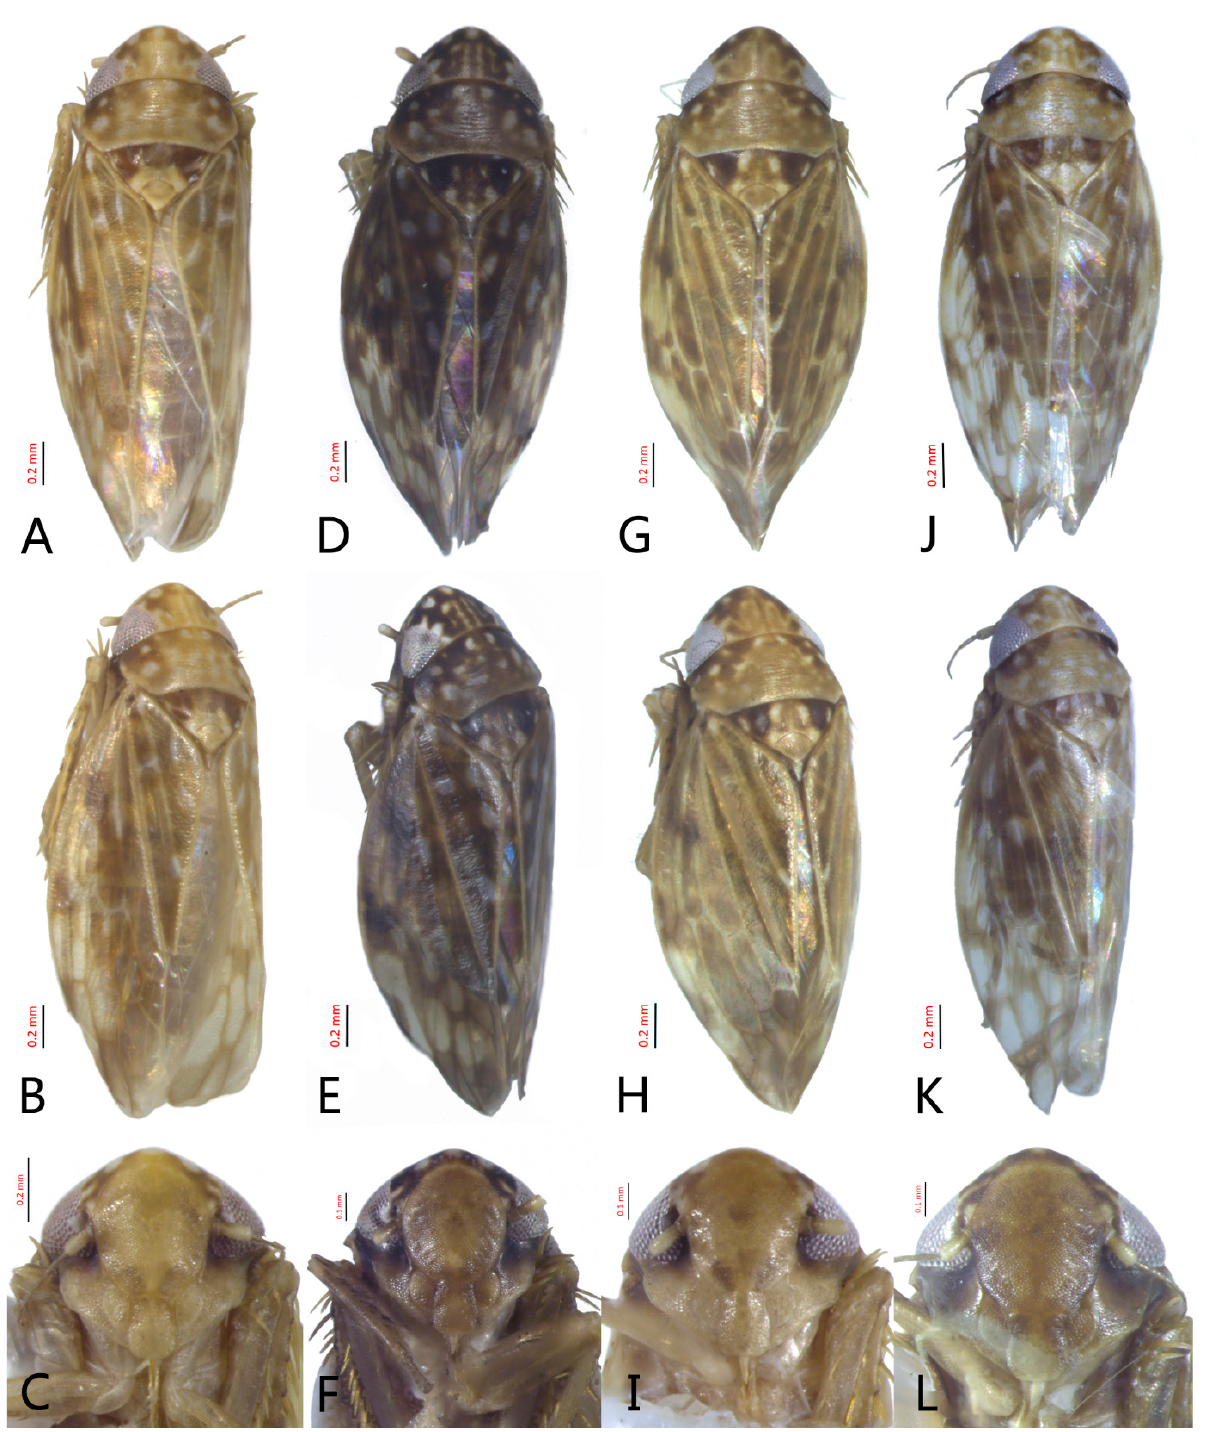
with two grayish-white irregular marginal spots on each side of anterior margin and one Xestocephalus asper Linnavuori, 1969: 1149, Figure 16a–c [64]; Linnavuori, 1979: 934, grayish-white marginal spot on each side of posterad of scutellar suture. Forewings with Figure 49a–c [24]. unpigmented spots pale. Ventral surface and legs uniformly dark brown.